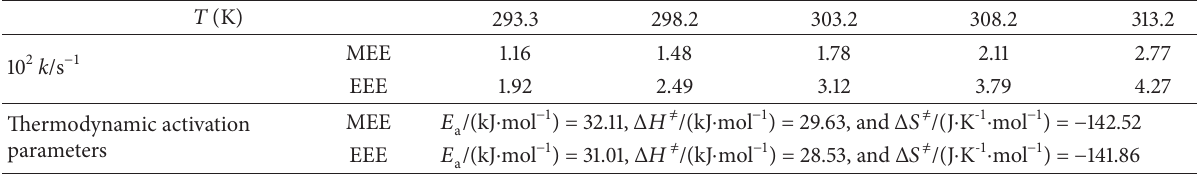
Table 4: Rate constants ( k ) and activation parameters of the rate-determining